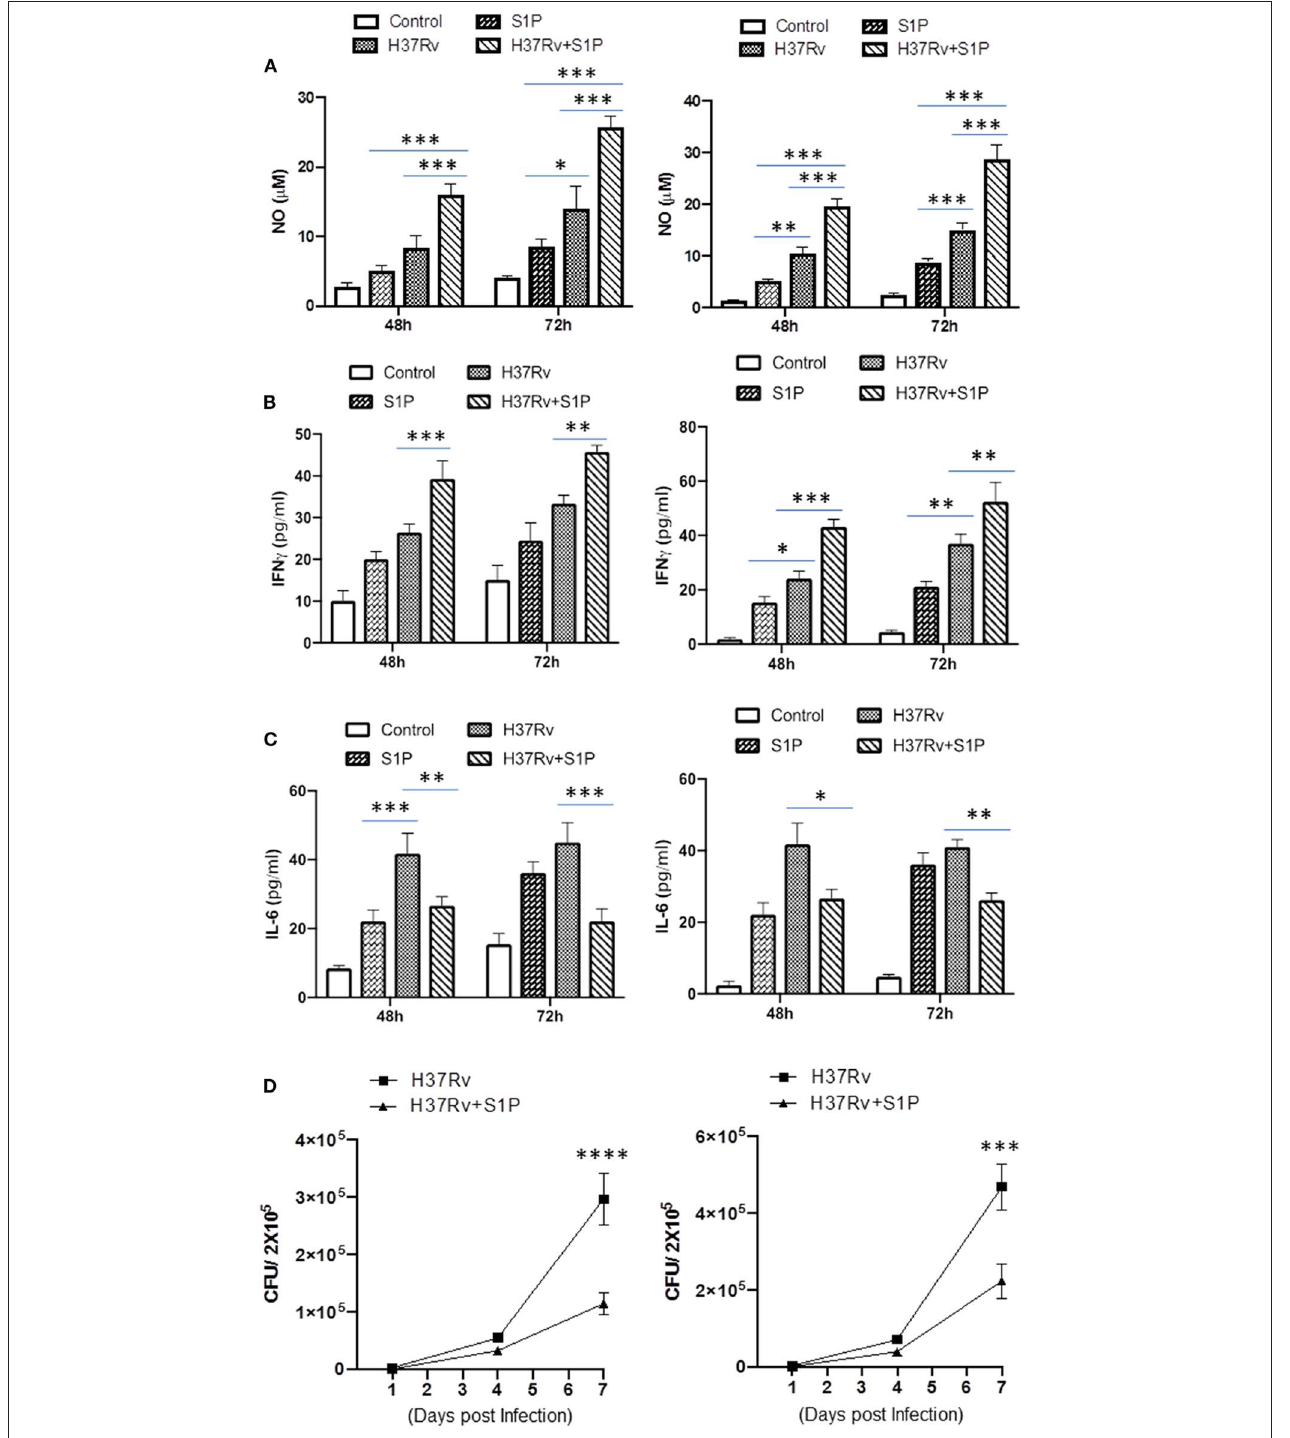
FIGURE 2 | RAW 264.7 macrophages (Left Panel) and BMDMs (Right Panel) were infected with M. tuberculosis in presence of S-1P. Titres of NO (A) , IFN- γ (B) , and IL-6 (C) were analyzed in their culture supernatant. Shown here is the µ M of NO ± SEM and pg/ml of cytokines ± SEM released during the course of infection from three independent experiments. Statistical analysis were conducted using two way Anova followed by Bonferroni post-test (* P < 0.05, ** P < 0.01, *** P < 0.001, **** P < 0.0001). (D) Anti-mycobacterial influence of S-1P was also analyzed in same cells. Shown here CFU ± SEM from three independent experiments.